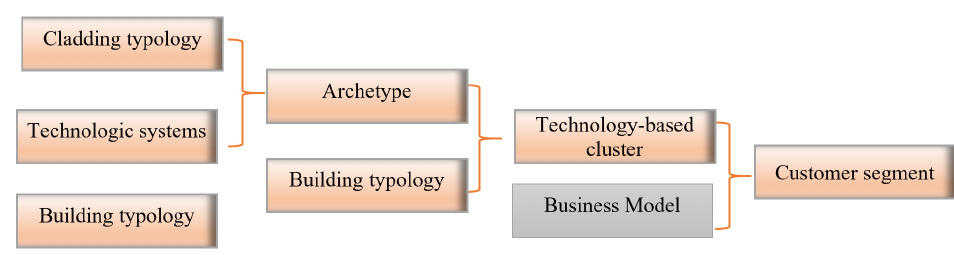
Figure 12. Market segmentation, including the economic and technical